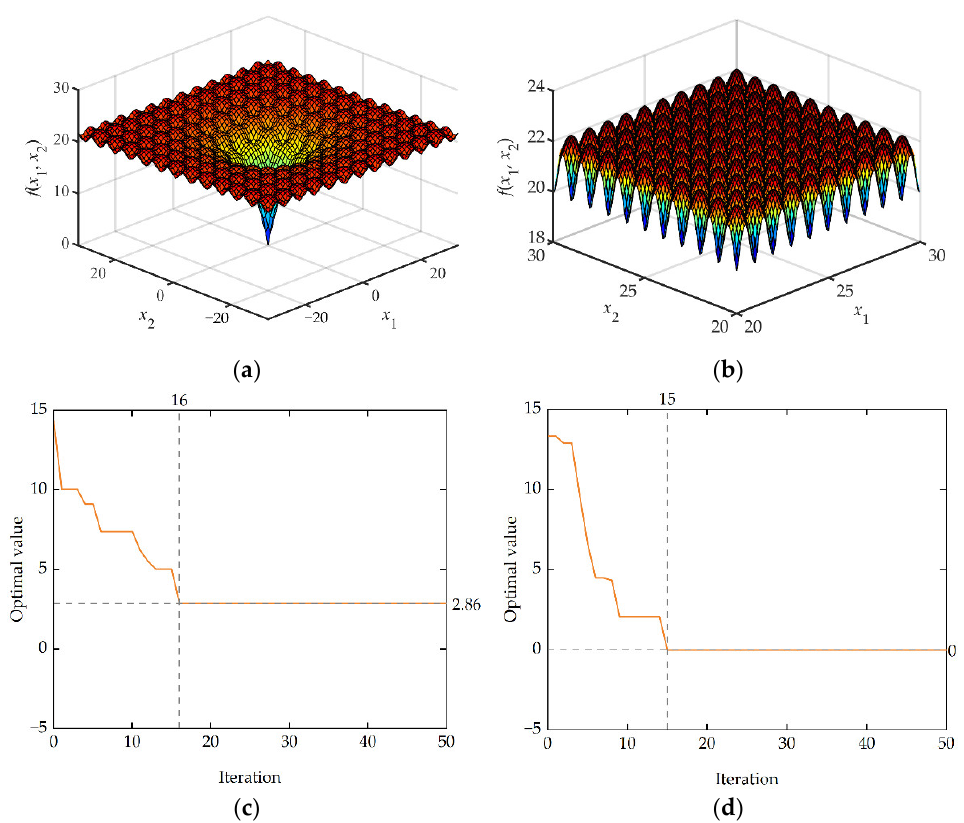
Figure 16. Benchmark function image and optimization convergence profile. ( a ) The 2-D Ackley function; ( b ) local schematic of Ackley function; ( c ) convergence profile of traditional EGO algorithm; ( d ) convergence profile of IEGO algorithm.